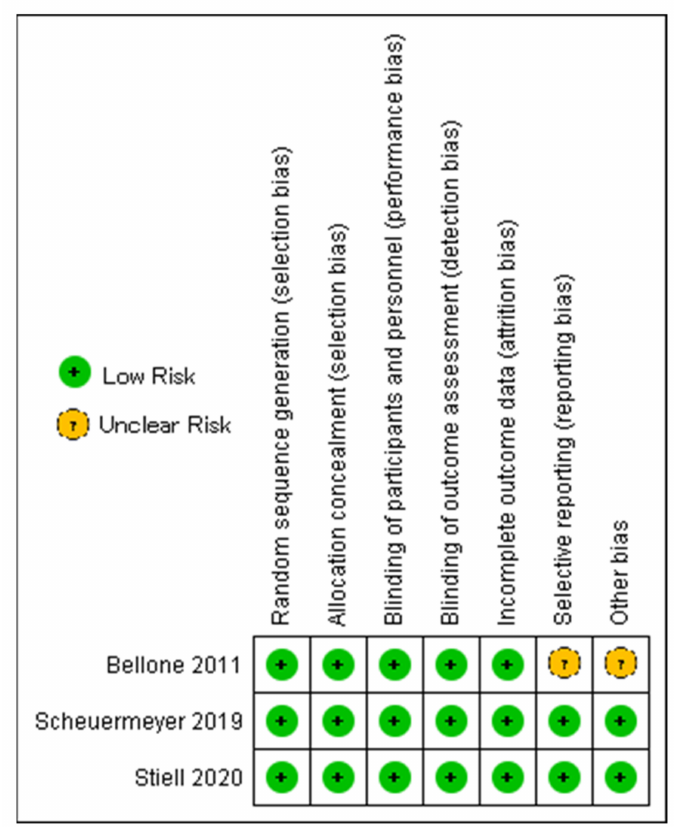
Figure 1. Risk of bias assessment of randomized controlled trials